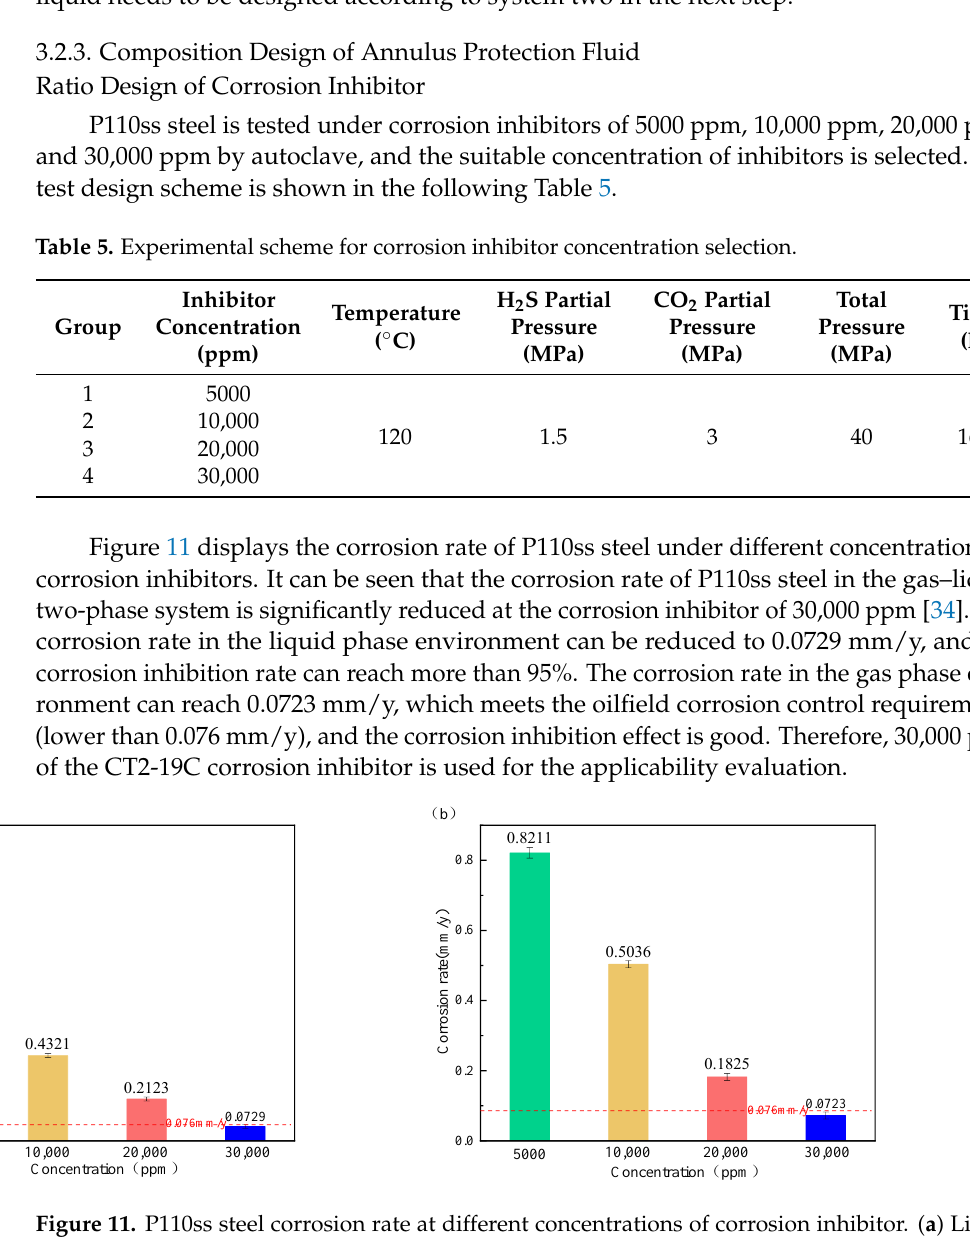
Figure 11. P110ss steel corrosion rate at different concentrations of corrosion inhibitor. ( a ) Liquid phase; ( b ) gas phase.